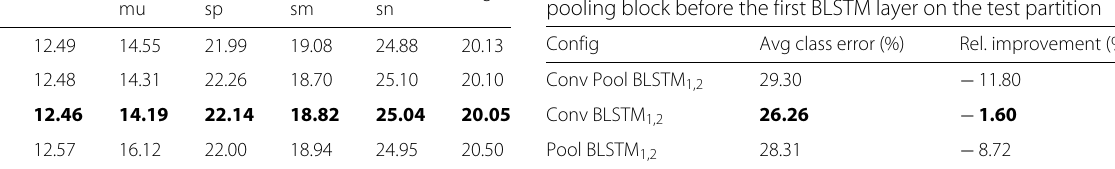
Table 4 SER, error per class and average class error for the RNN classifier combined with the resegmentation module over test partition for the best feature configuration and different values of the down-sampling factor, L , and minimum segment length, T min L , T min